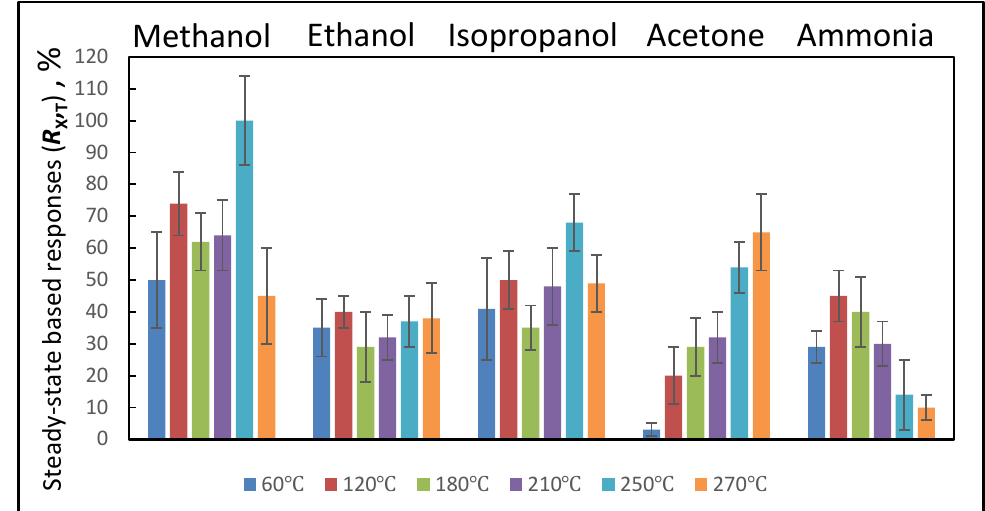
Figure 6. Normalized steady-state assessment based analytical signals ( R X , T ) of WO 3 /WO 3 − x -based sensing layer towards VOCs (methanol, ethanol, isopropanol, acetone) and ammonia gas at 60, 120, 180, 210, 250, and 270 °C temperatures.